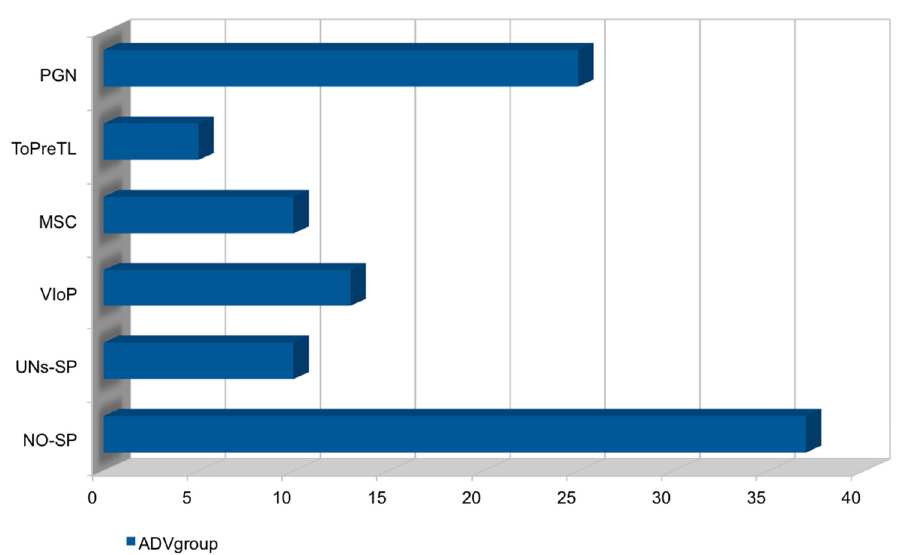
Figure 3. Obstetric outcome in COVID-19 vaccinated women whose menstrual irregularities could be adverse effects to vaccine. Legend and abbreviations: y = women not seeking pregnancy, NO-SP/women unsuccessfully seeking pregnancy, UNs-SP/women undergone voluntary interruption of pregnancy, VIoP/cases of miscarriages, MSC/cases of threat of preterm labor, ToPreTL/women got pregnant, PGN; x = number of vaccinated women.